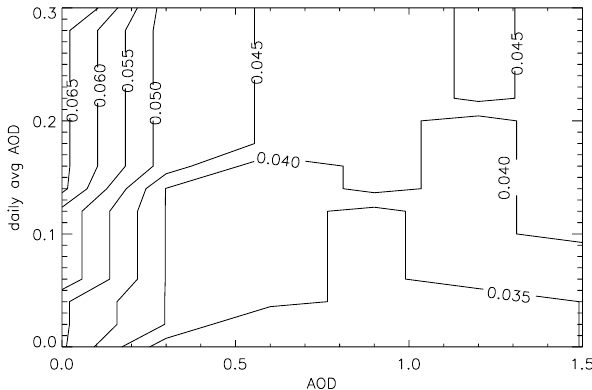
Fig. 10. Histogram of daily standard deviation of AOD with average values less than 0.3 at the three AERONET sites, from 2001 to 2008.